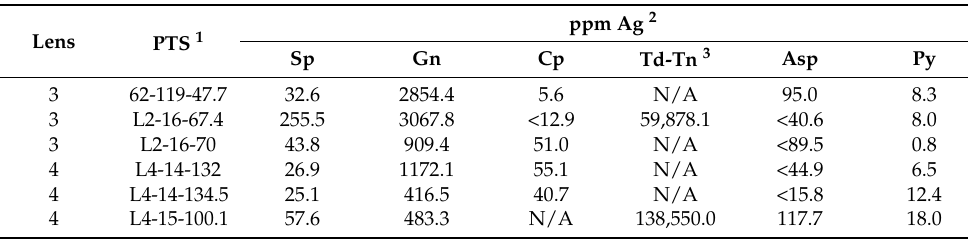
Table 4. LA-ICP-MS Ag average grain concentrations.